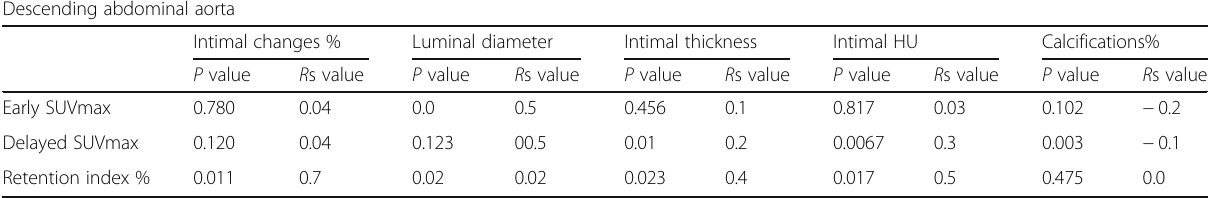
Table 9 Correlation between FDG findings and CT findings in the 50 patients of study population within the descending abdominal aorta Descending abdominal aorta Intimal changes % Luminal